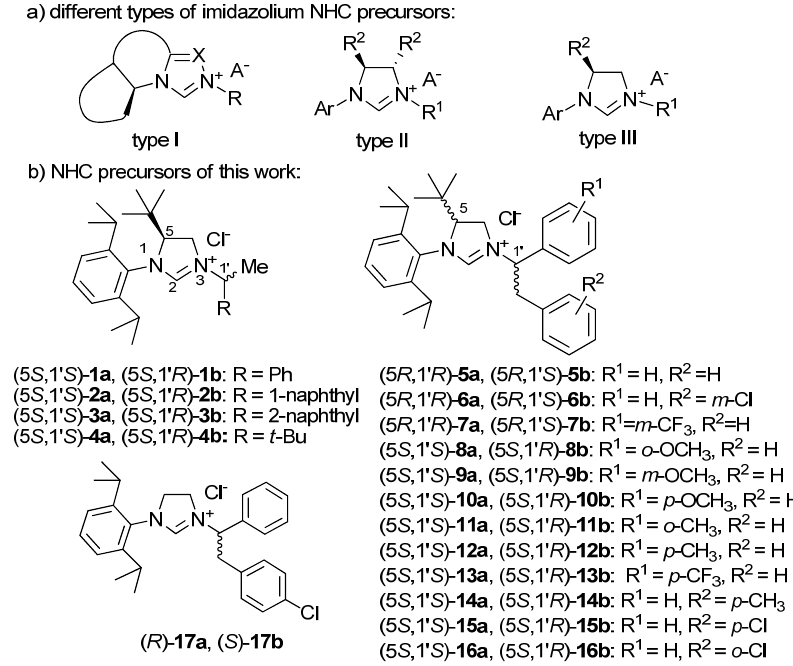
Figure 1. ( a ) Different types of chiral non-racemic imidazolium NHC precursors. ( b ) Structures of the NHC precursors included in the present study.